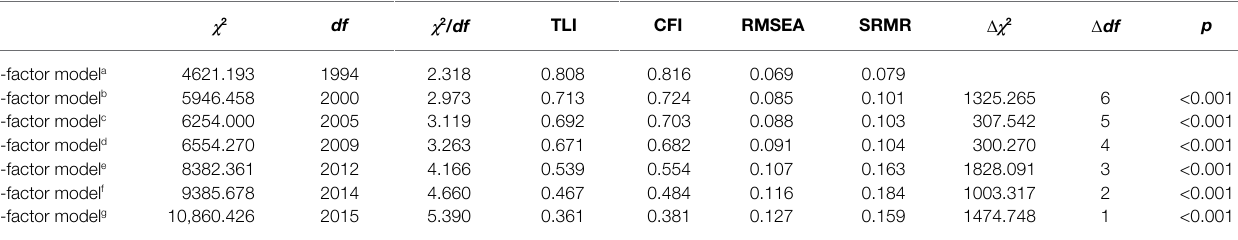
TABLE 2 | Results of confirmatory factor